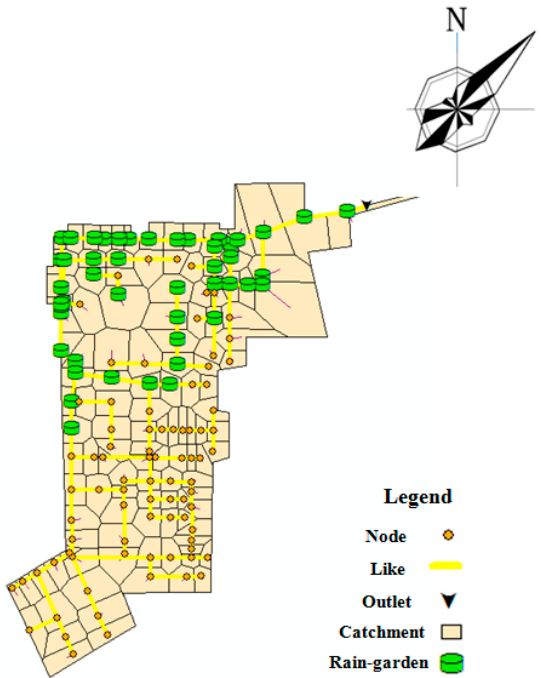
Figure 4. Simulation of rain garden in the MIKE model.